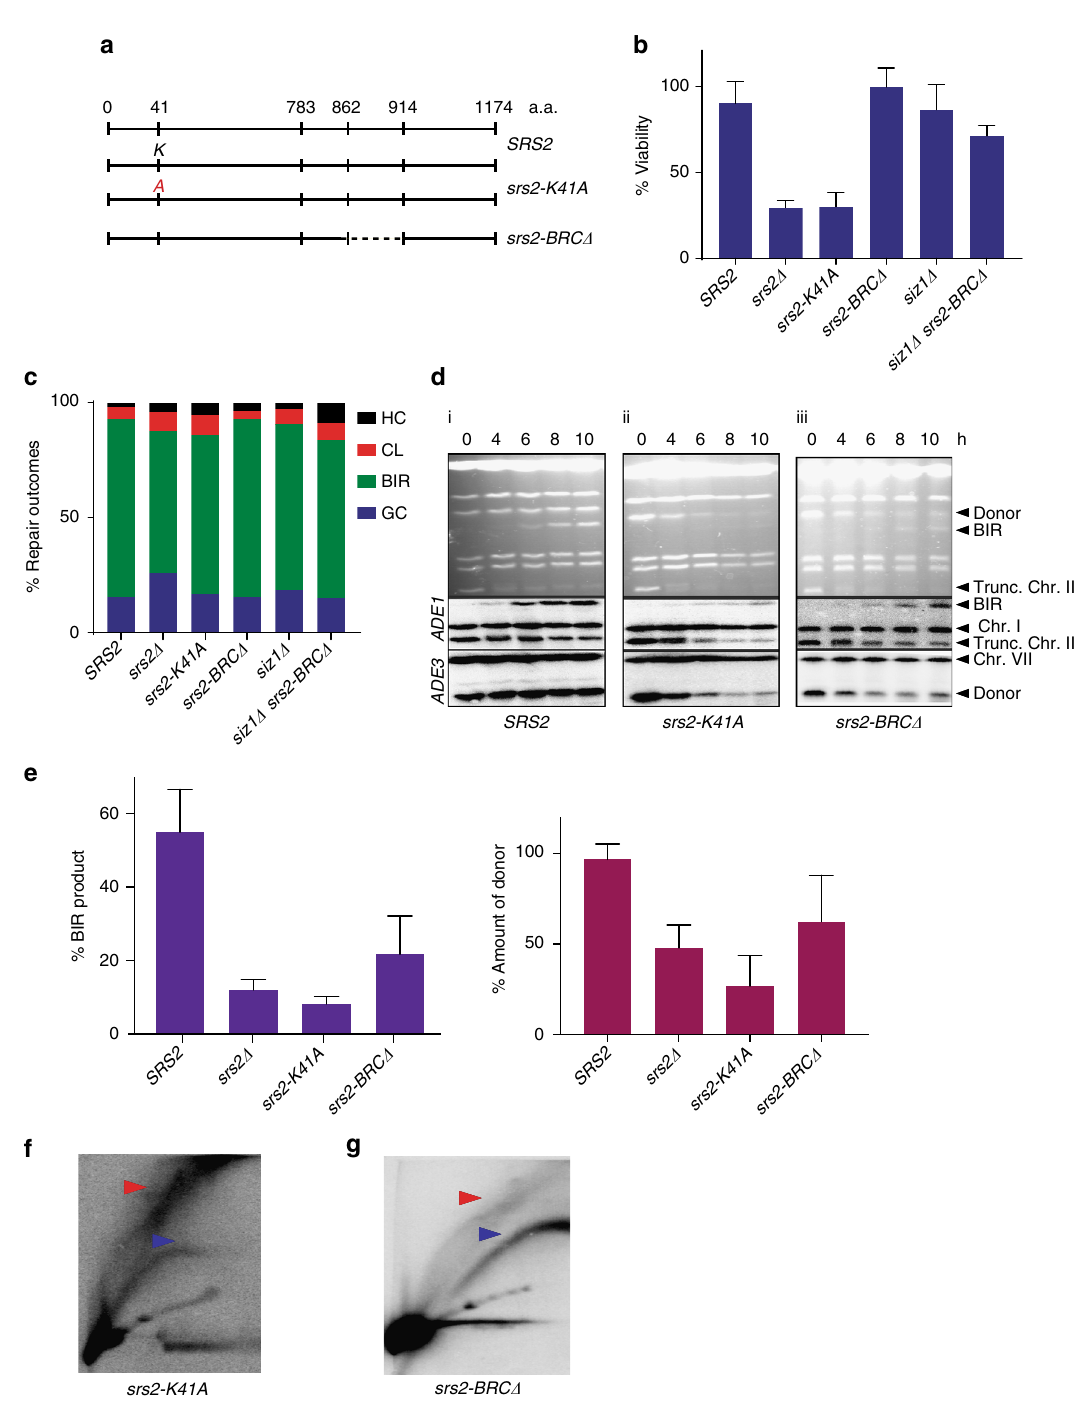
Fig. 3 The defects in the helicase and strippase activities of Srs2 interfere with BIR progression. a The schematic of Srs2 (WT) and of srs2 mutations srs2- K41A and srs2-BRC Δ . “ A ” represents the position where lysine is replaced by alanine resulting in the ATPase (strippase and helicase) defect. Dotted line denotes deletion of SRS2 BRC domain. b Cell viability following DSB induction in SRS2 , srs2 Δ , srs2-K41A, srs2-BRC Δ , siz1 Δ and siz1 Δ srs2-BRC Δ . c Distribution of DSB repair outcomes following BIR repair in various mutants shown in b . d BIR kinetics in srs2-K41A and srs2-BRC Δ analyzed by CHEF (see Fig. 1e for details). e Quanti fi cation of BIR product (left) and of donor entering the gel (right) measured at 8 h after DSB. f , g 2D analysis of BIR in srs2-K41A and srs2- BRC Δ , respectively A probe speci fi c to 24 kb away from the DSB was used. Blue and red arrowheads denote bubble arc intermediate and ‘ rubble ’ structure respectively. Quanti fi cation of cell viability, amount of BIR product, and amount of donor was based on ≥ 3 independent experiments and are presented as means with standard deviations